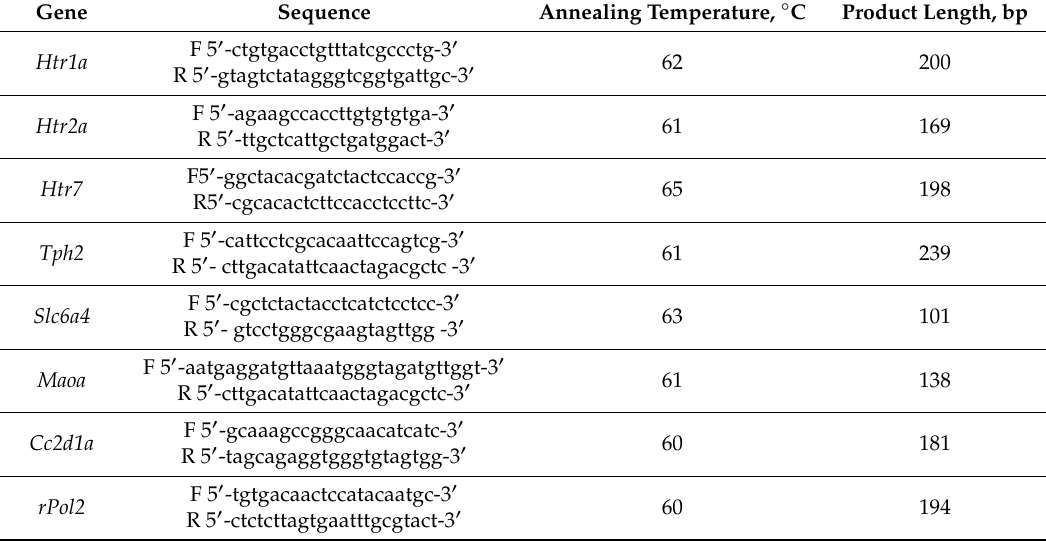
Table 2. The primer sequences, annealing temperatures and PCR product